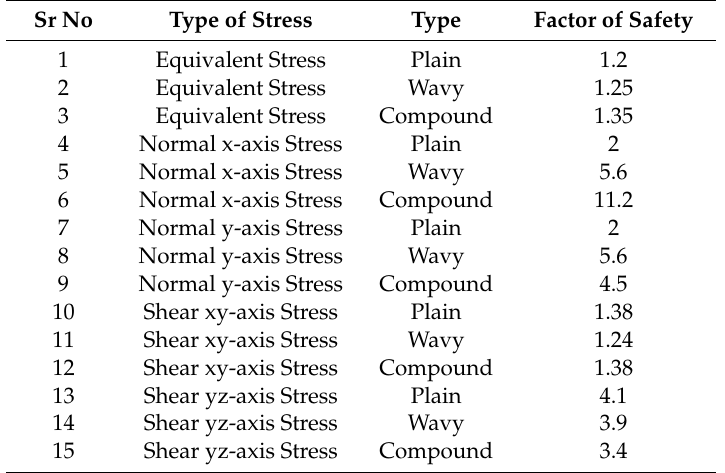
Table 6. Factor of safety along path 4 for plain, wavy and compound